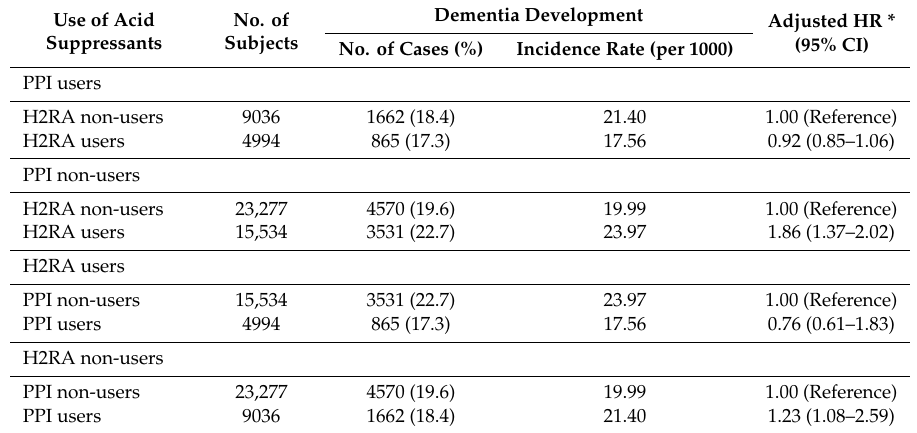
Table 3. Risk of dementia associated with exposure to histamine 2 receptor antagonists (H2RAs) stratified by the use of proton pump inhibitors